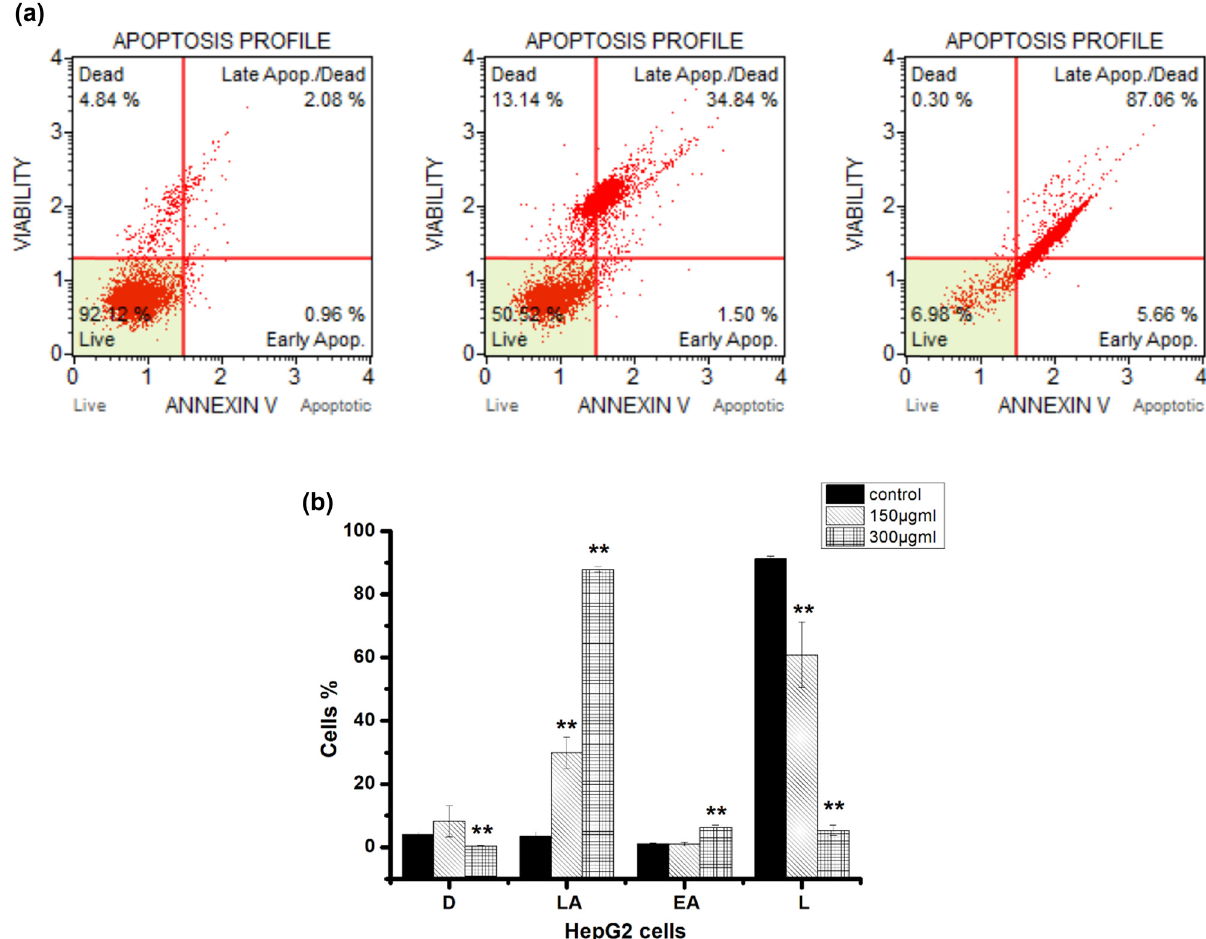
Figure 3: Hexane propolis extract induced HepG2 cell apoptosis at 150 and 300µg/mL. ( a ) In each panel, the lower left quadrant designates live cells ( dead cell marker ( – ) andannexin v ( – )) ,lower - right quadrant designates earlyapoptosis ( dead cellmarker ( – ) andannexin v (+)) , upper right quadrantdesignateslateapoptosis ( deadcellmarker (+) andannexinv (+)) ,andupperleftquadrantdesignatesnecroticcells ( deadcellmarker (+) and annexin v ( – )) . ( b ) Proportions of dead cells ( D ) , live cells ( L ) , early apoptotic cell ( EA ) , and late apoptotic cell ( LA ) . Data presented as